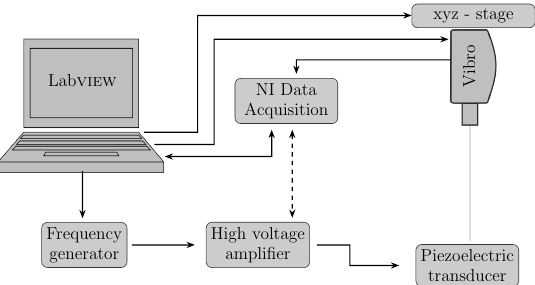
Figure 3. Schematic showing the dynamic experimental measurement setup.